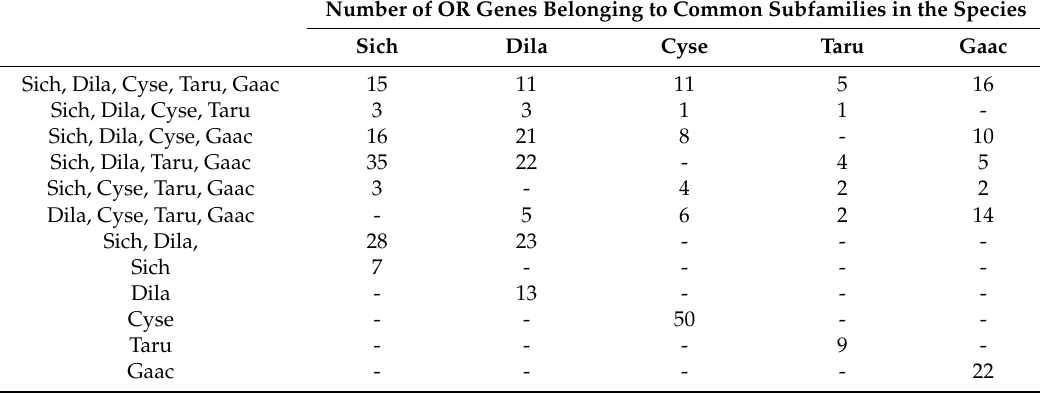
Table 3. Number of species-common or special OR genes among five Percomorpha fish OR repertoires. Number of OR Genes Belonging to Common Subfamilies in the